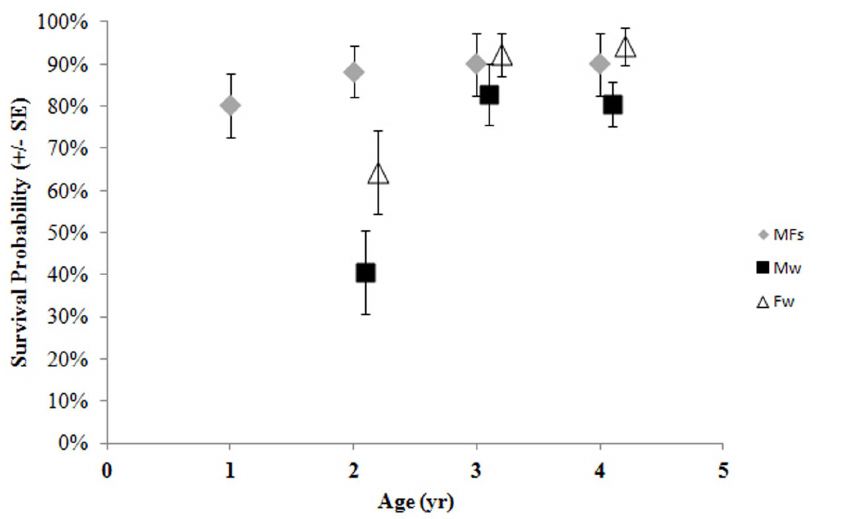
Figure 3. Model-averaged survival estimates ( ± SE) of Steller sea lions to ages 1 – 4 for suckling males and females (MFs), weaned males (Mw) and weaned females (Fw).